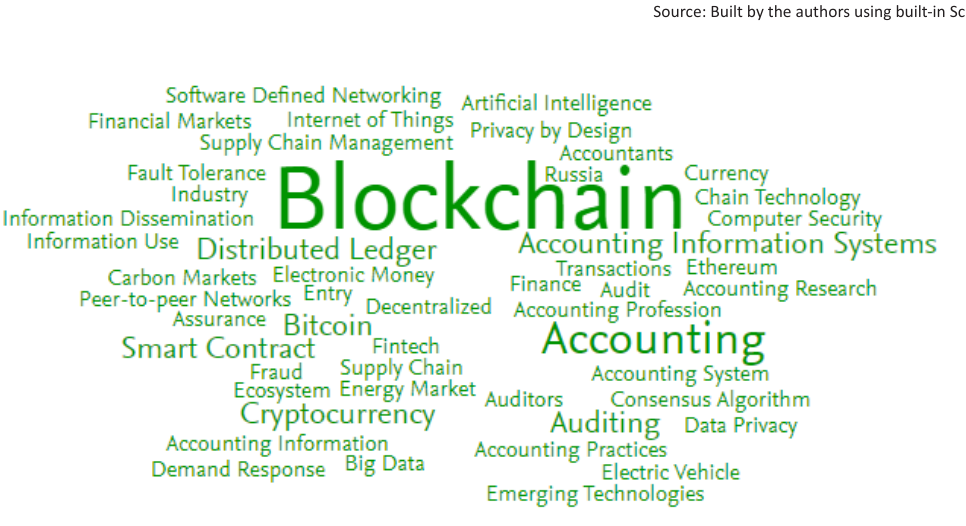
Figure 4. Top 50 key phrases by relevance for “blockchain” AND “accounting”